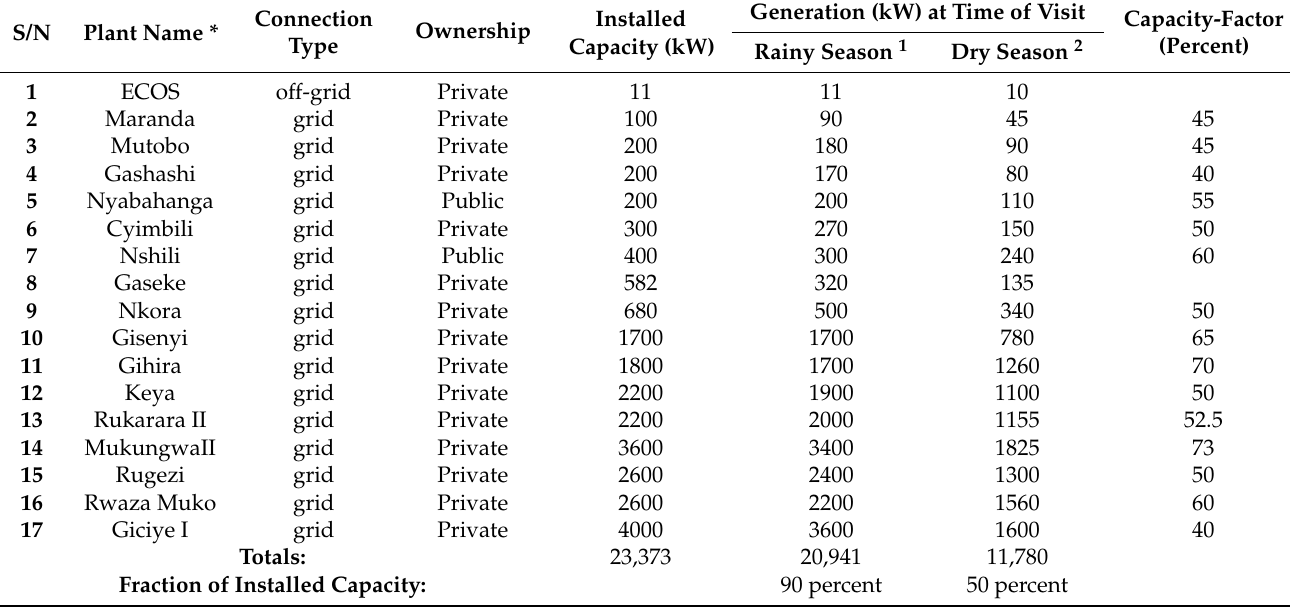
Table 2. Plants in the sample study technical characteristics and current